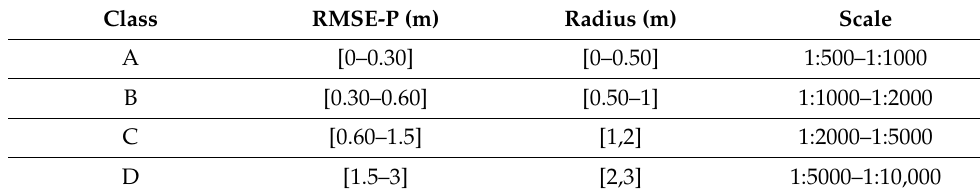
Table 1. Classification of anchor points (conformance